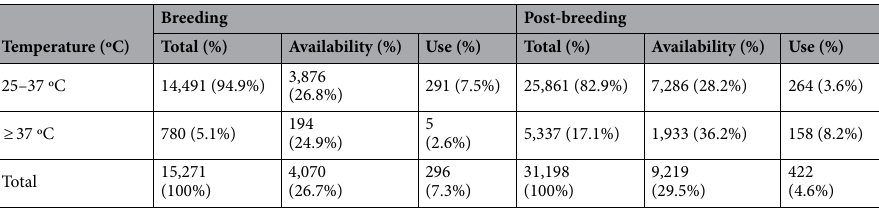
Table 1. Summary information of microclimate refugia availability in the buffer area and use by little bustard at above optimal temperature (25–37ºC) and at thermal stress temperature (> 37 °C), for both breeding and post-breeding seasons (Fig. 2).